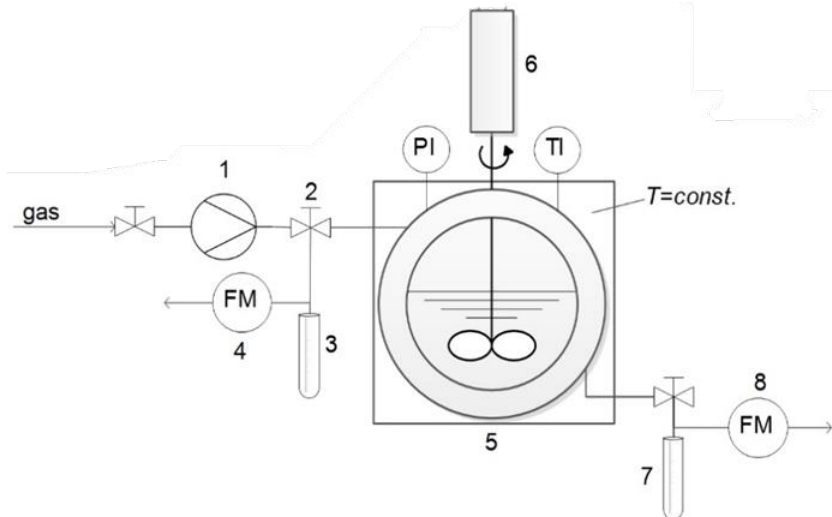
Figure 1. A scheme of a variable-volume high-pressure optical view cell for the determination of the solubility of argon-butanol isomer systems: 1-driven gas booster; 2-argon supply valve and valve for gas-rich phase sampling; 3-glass trap for sampling; 4-gas flow meter; 5-optical view cell; 6-propeller mixer; 7-glass trap for sampling; 8-gas flow meter [24].